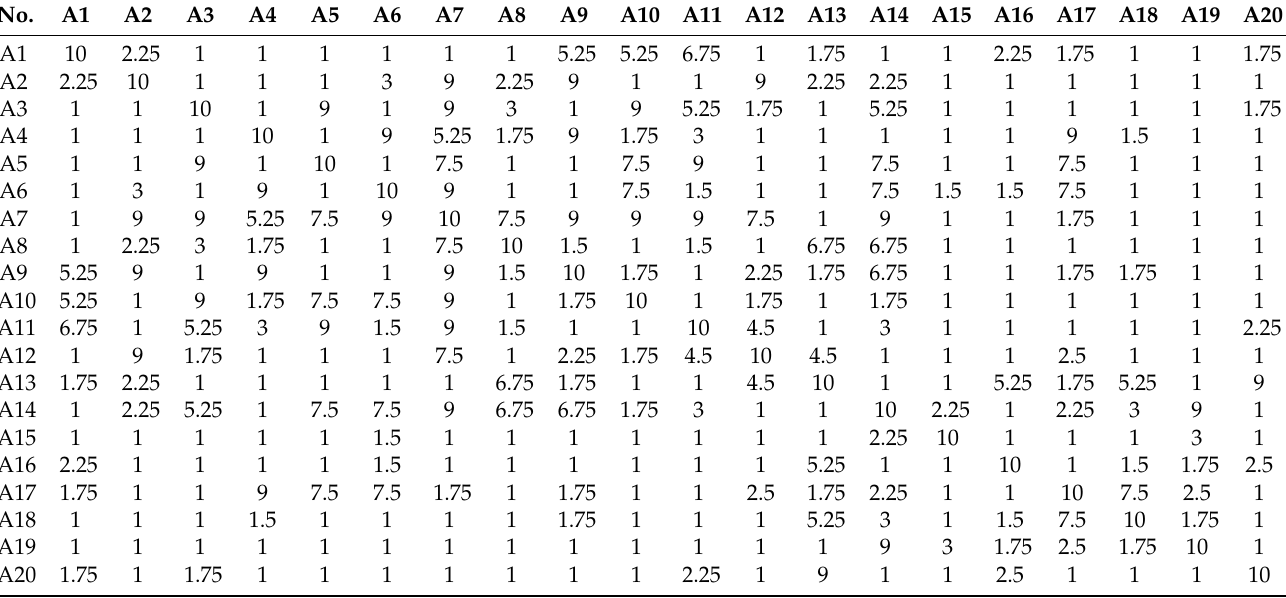
Table 16. The correlation matrix of agility criteria.